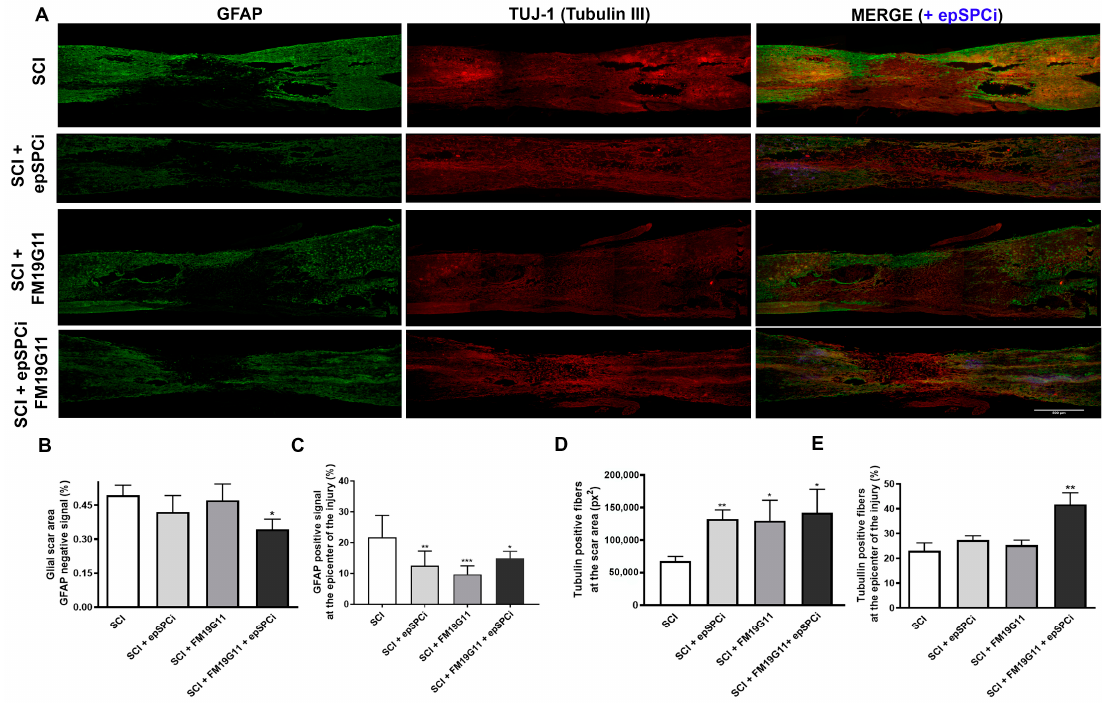
Figure 3. Combinatory treatment reduces the glial scar formation and preserves larger numbers of neuronal fibers. ( A ) Representative immunofluorescence images from glial fibrillary acidic protein (GFAP; green ), β -tubulin-III ( red ) and merge including green fluorescence protein (GFP)-epSPCi in the transplanted groups (GFP, blue ) with positive signals at the epicenter of the injury from spinal cord longitudinal sections in every experimental condition; Scale bar, 500 µm; ( B ) quantification of the negative area or ( C ) the positive signal at the injury site for GFAP expressed as a percentage of the total epicenter area, equivalent in length for all tested groups; ( D ) quantification of the positive signal for β -tubulin-III (tubulin) at the negative GFAP area or ( E ) covering all the injury area, expressed as a percentage of the total epicenter area, equivalent in length for all tested groups. Quantitative data are expressed as the mean ± S.E.M; * p < 0.05, ** p < 0.01, *** p <0.001 in comparison with SCI (control).